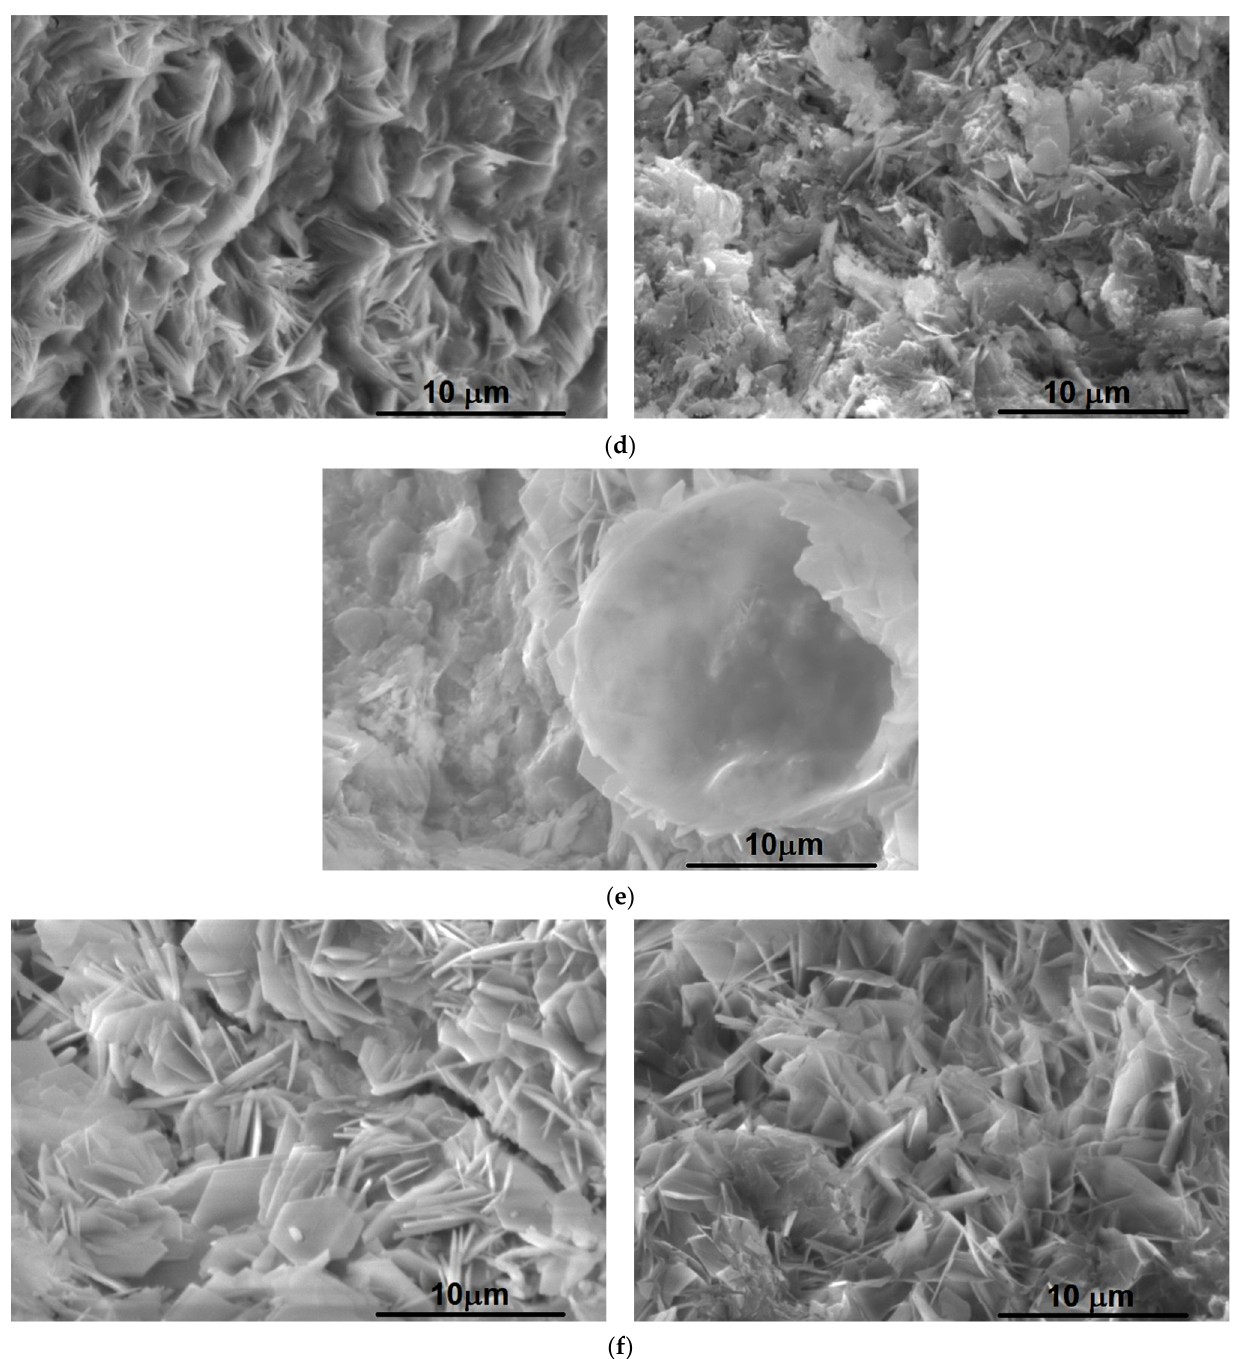
Figure 6. Scanning electron microscopy images performed on mortars at 7 and 28 curing days: ( a ) CI at 7 days; ( b ) CI at 28 days; ( c ) CIIAS at 7 days; ( d ) CIIAS at 28 days; ( e ) CIIBM at 7 days; and ( f ) CIIBM at 28 days.